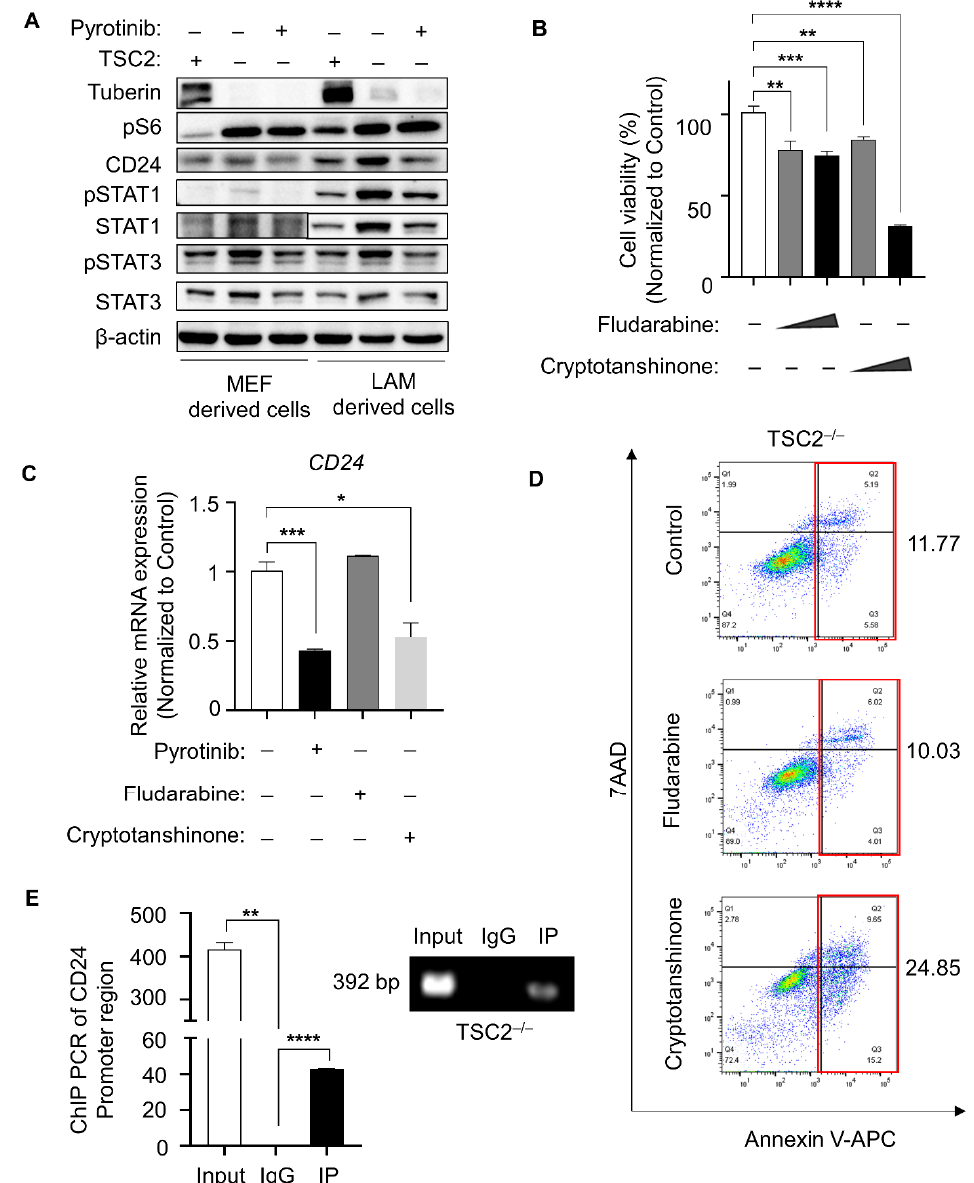
Figure 3. CD24 transcriptional level upregulated by phosphor-STAT3. ( A ) Indicated proteins were detected in MEF- and LAM-derived cells treated with or without pyrotinib (1 µ M). ( B ) TSC2-deficient MEF-derived cells were treated with fludarabine (0.5 µ M or 1 µ M) or cryptotanshinone (0.5 µ M or 1 µ M) for 48 h, CCK8 assay was used to monitor cell viability ( n = 5). ** p < 0.01, control versus fludarabine (0.5 µ M). *** p < 0.001, control vs. fludarabine (1 µ M). ** p < 0.01, control vs. cryptotanshinone (0.5 µ M). **** p < 0.0001, control vs. cryptotanshinone (1 µ M), Student t test. ( C ) mRNA expression changes of CD24 was detected by qPCR ( n = 3) in TSC2-deficient cells treated with or without pyrotinib (1 µ M), fludarabine (1 µ M) and cryptotanshinone (1 µ M). *** p < 0.001, Control vs. pyrotinib. * p < 0.05, control vs. cryptotanshinone, Student t test. ( D ) TSC2-deficient MEF-derived cells were treated with fludarabine (1 µ M) or cryptotanshinone (1 µ M) for 48 h. Cells were stained with the Kit. ( E ) RT-PCR was performed to determine gene abundance of CD24 promoter region in the groups of positive control (Input), negative control (IgG) and IP, which were immunoprecipitated with anti-pSTAT3 antibody in TSC2-deficient MEF-derived cells. ** p < 0.01, input vs. IgG. **** p < 0.0001, IgG vs. IP, Student t